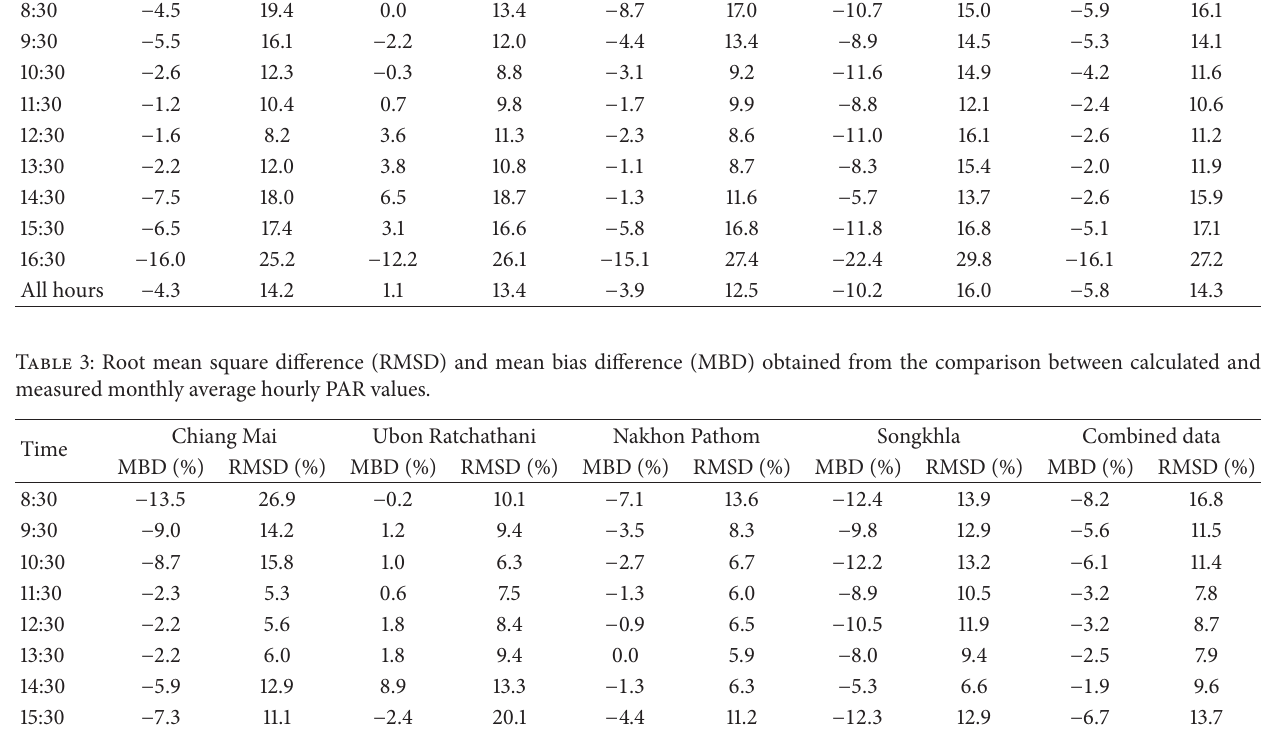
Table 2: Root mean square difference (RMSD) and mean bias difference (MBD) obtained from the comparison between calculated and measured hourly PAR values. Chiang Mai Ubon Ratchathani Nakhon Pathom Songkhla Time